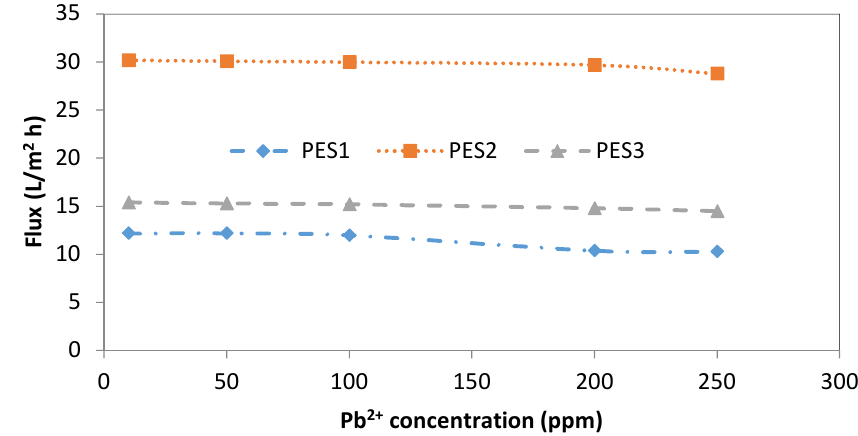
Figure 7. Effect of Pb 2+ initial concentration on permeate flux of PES1, PES2, and PES3 membranes (experimental conditions: pH = 6 ± 0.2, transmembrane pressure of 1 bar).